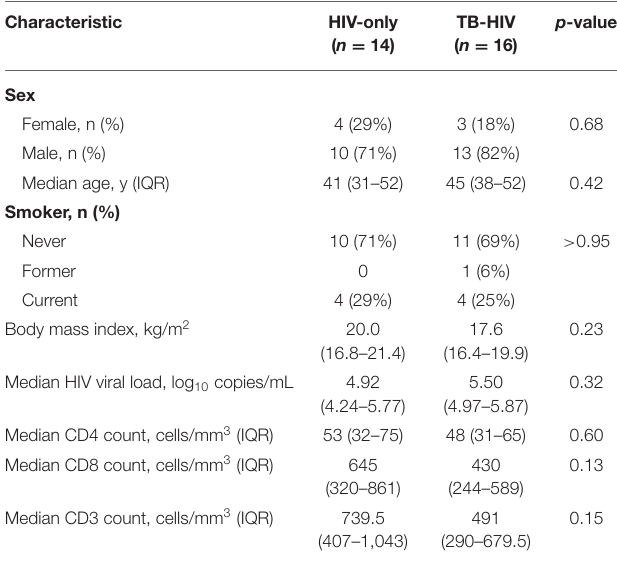
TABLE 1 | Baseline characteristics among cases (TB-HIV) and controls (HIV-only) enrolled in the India cohort ( n = 30).